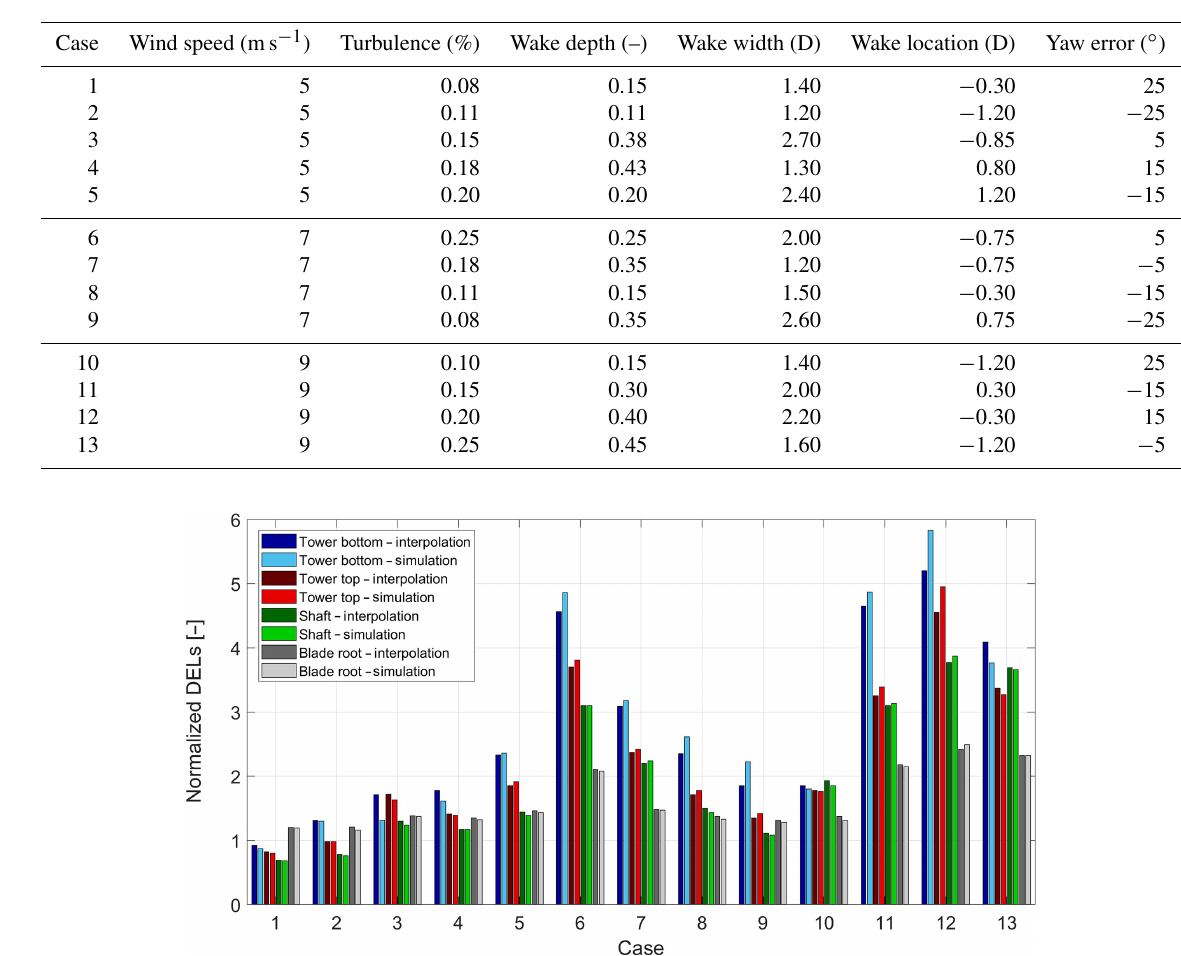
Figure 2. Visualization of interpolation and BEM simulation results. The loads are normalized with respect to the loads in nominal (offset- free) free-stream operation at a wind speed of 8 ms − 1 and turbulence of